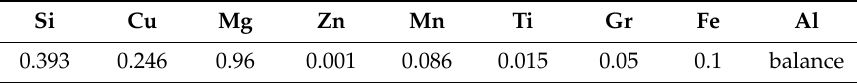
Table 1. Chemical component of AA6061